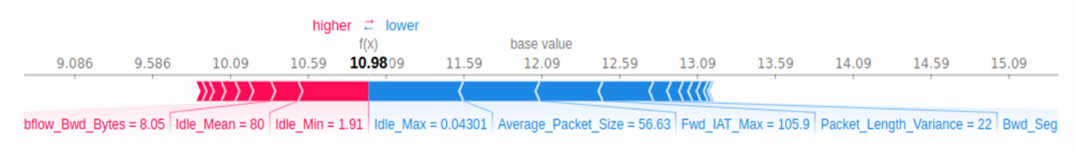
Figure 10. Explanation of a single prediction (50,000 evaluations).